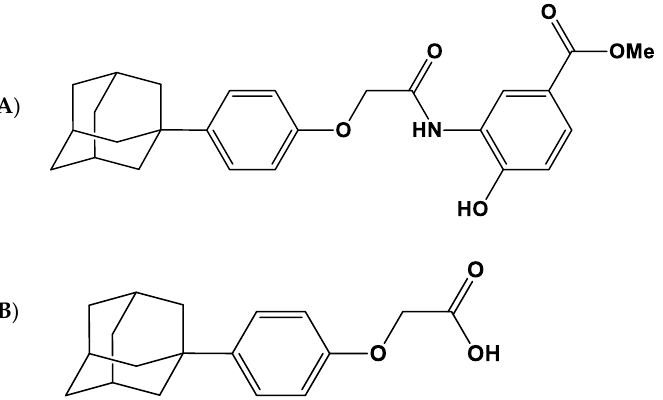
Figure 5. Structures of LW6 ( A ) and its metabolite, 2-(4-((3R, 5R, 7R)-adamantan-1-yl phenoxy)acetic acid (APA) ( B ).